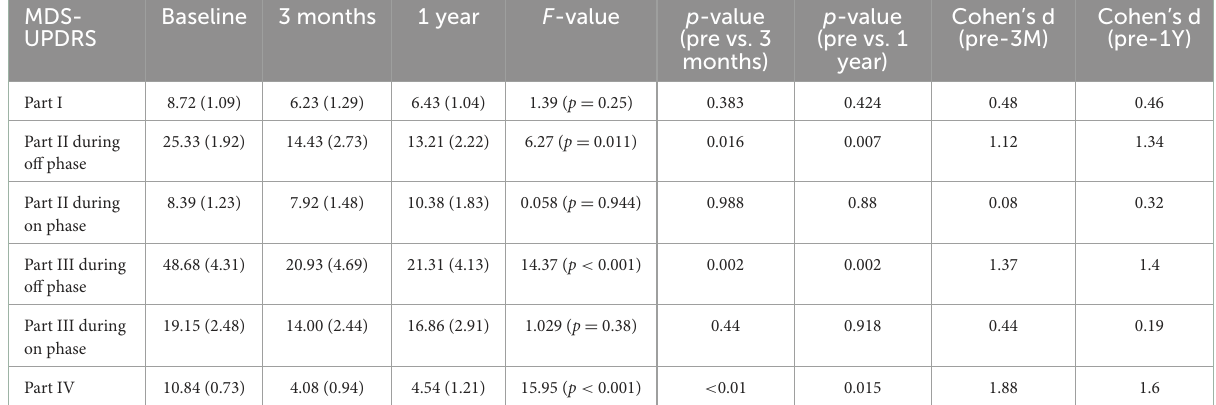
TABLE 2 Scores for MDS-UPDRS at baseline and follow-up points after surgery (3 months and 1 year after surgery). MDS-